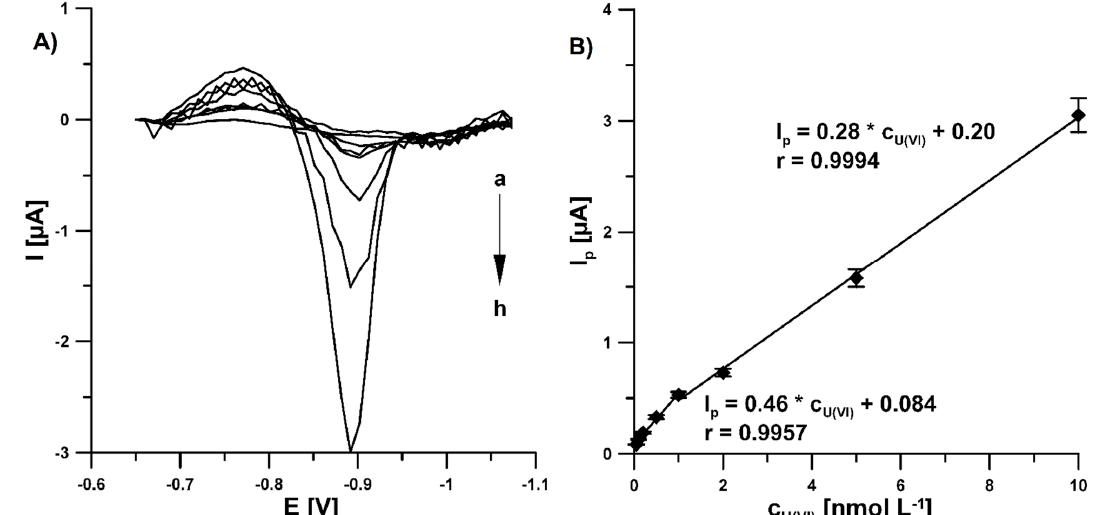
Figure 9. ( A ) SWAdSVs recorded at the Pb-N-CMK-3/GCE in the buffer solution (0.385 M CH 3 COONH 4 , 0.615 M CH 3 COOH and 0.615 M NH 4 Cl) of pH = 4.2 ± 0.1 containing 25.0 μ M Pb(NO 3 ) 2 , 0.08 mM cupferron and increasing concentrations U(VI): (a) 0.05, (b) 0.1, (c) 0.2, (d) 0.5, (e) 1.0, (f) 2.0, (g) 5.0, (h) 10.0 nM. ( B ) Calibration plot of U(VI). The SWAdSV parameters: E dep and acc of − 0.8 V, t dep and acc of 180 s, f of 100 Hz, E SW of 100 mV and Δ E of 10 mV.